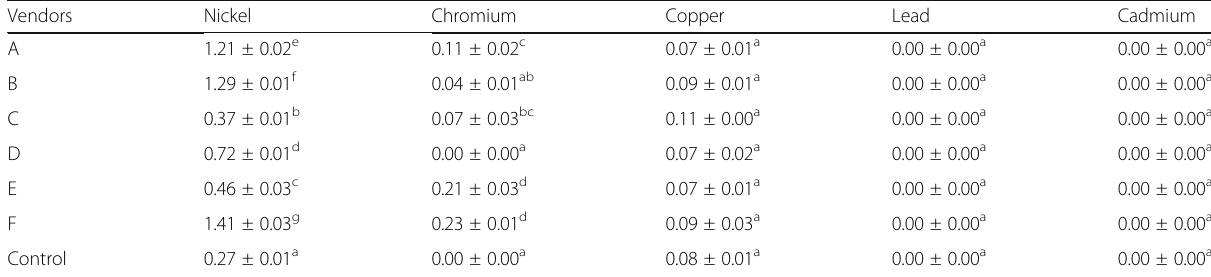
Table 2 Concentration (mg kg − 1 ) of heavy metals in sliced watermelon fruits purchased from Shasha market